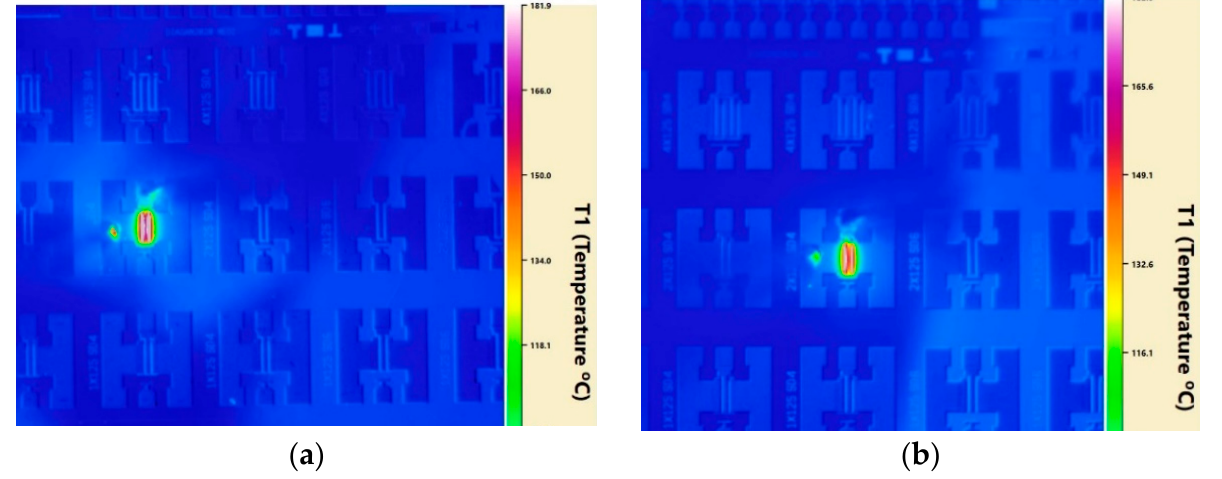
Figure 8. Junction temperature of GaN HEMTs with NDC ( a ) and SiN ( b ) passivated structure measured by IR thermal photogrammetry.